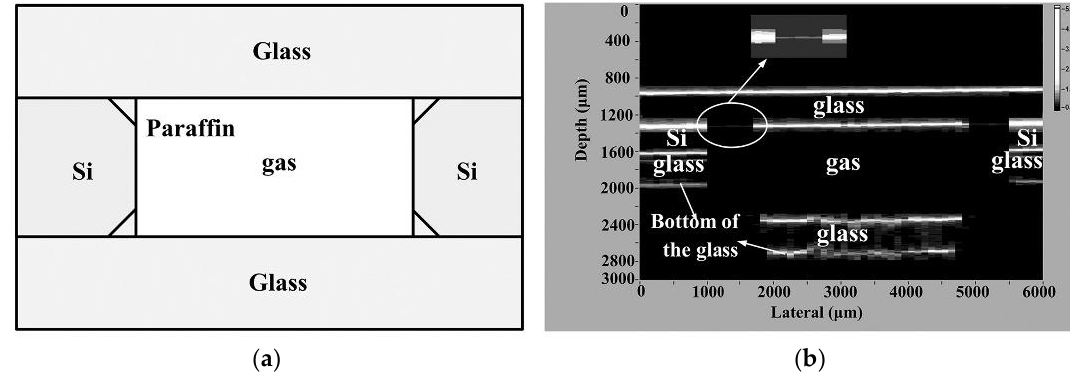
Figure 17. Measurement of the sandwich type sample: ( a ) the profile of the sample, and ( b ) the scanning image of the sandwich type sample. (Figure reproduced from Ref. [81]).